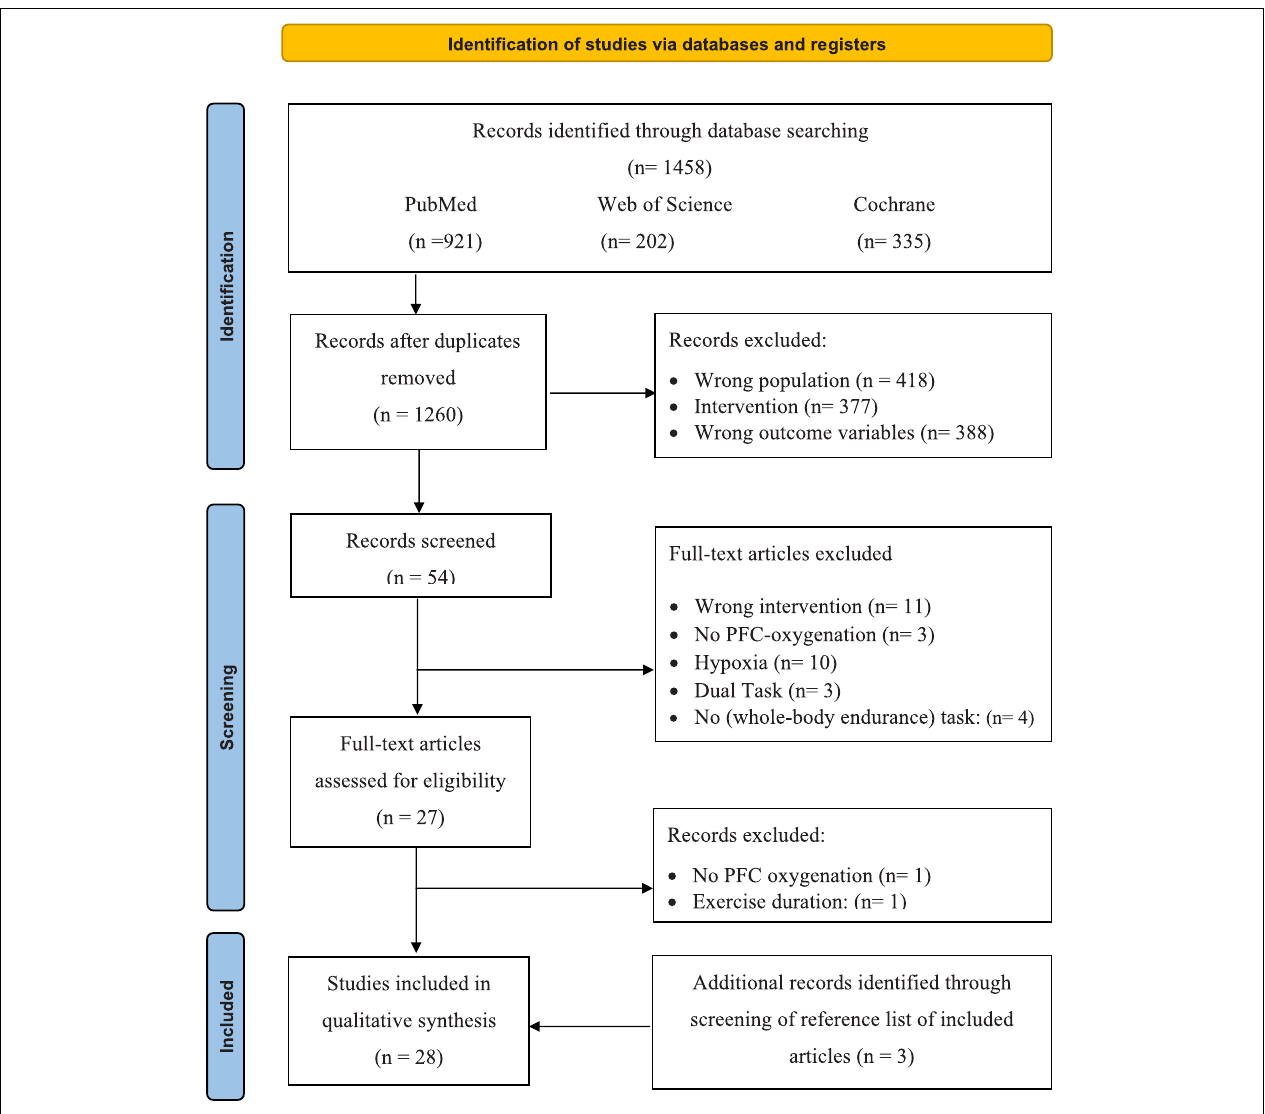
FIGURE 1 | Selection process for research articles ( n = 28) included in this systematic review. Adapted version of the recommendations in the PRISMA 2020 statement (Liberati et al., 2009). nRCT, non-randomized controlled trial; nRnCT, non-randomized non-controlled trial; RCT, randomized controlled